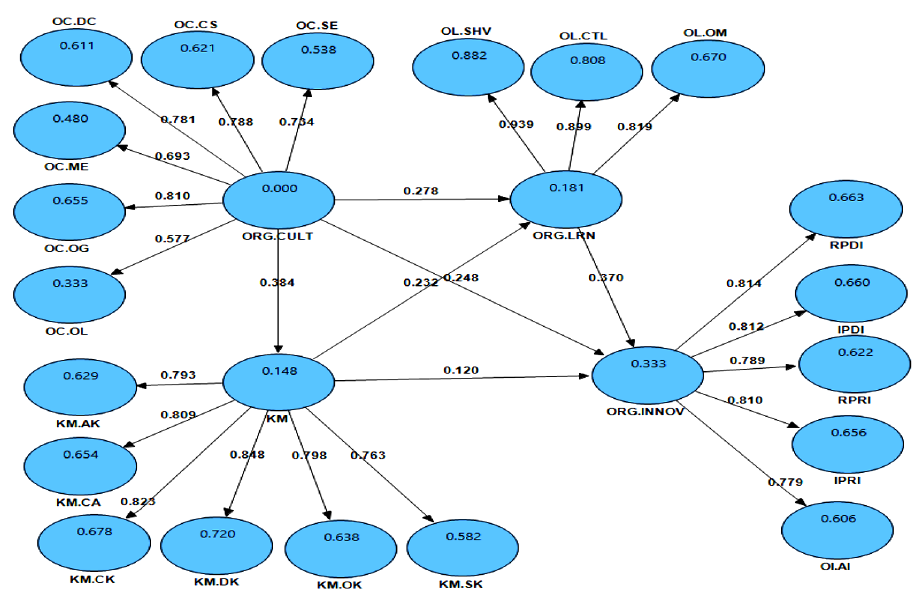
Figure 3. PLS algorithm results for the structural